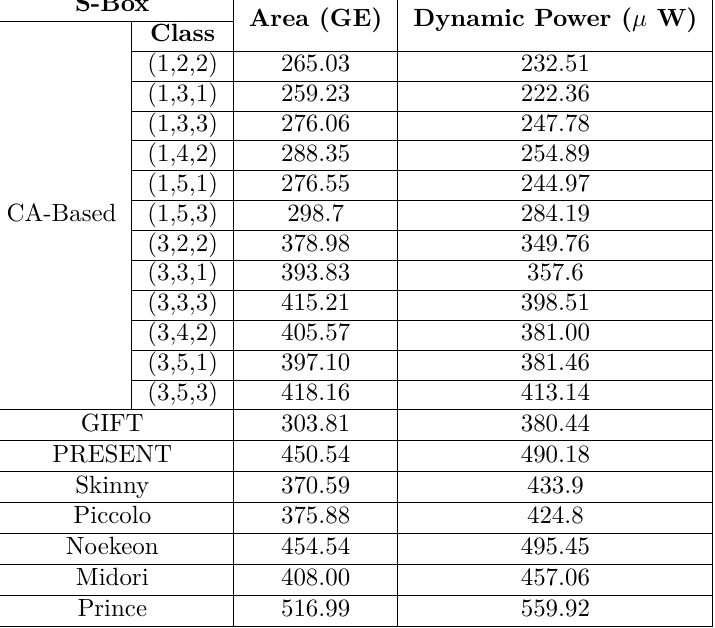
Table 3: TI of CA-based S-Box representatives: area and power consumption (ASIC Technology: